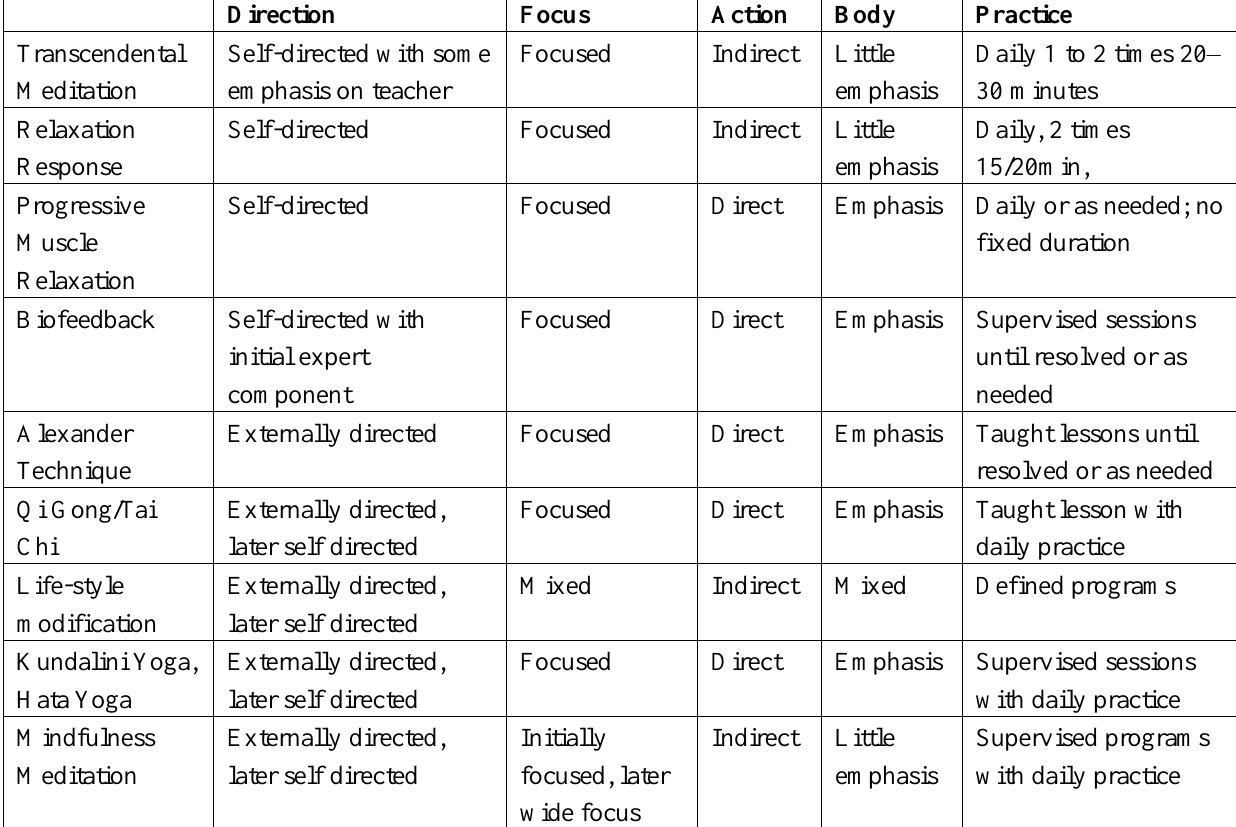
Table 1. Summary Classification of Some Better Known Mind-Body